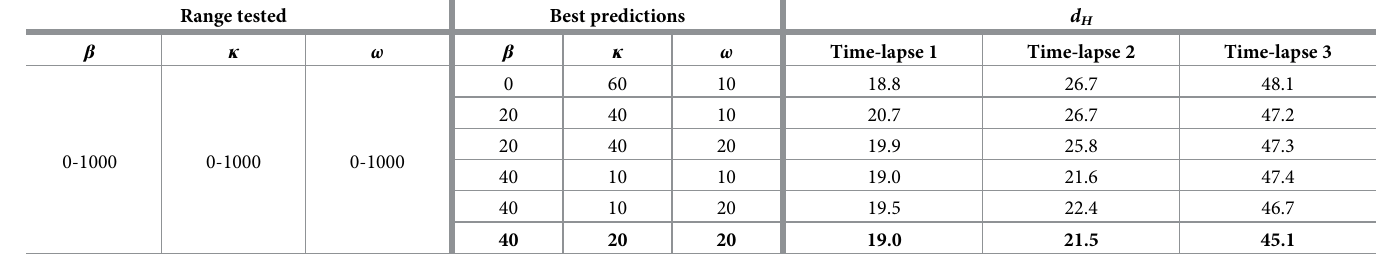
Table 2. Best six values for β , κ , and ω from analysis of Time-lapse 1. Results of the six best predictions represented by smaller d variable which provides the smallest d H for all cases was selected